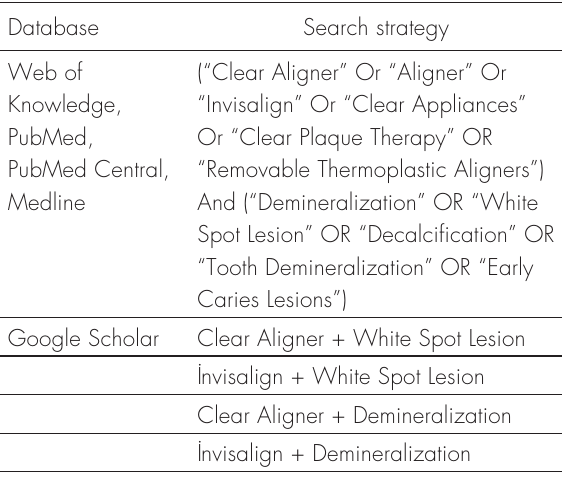
Table I. Computerized search terms on the electronic sources.